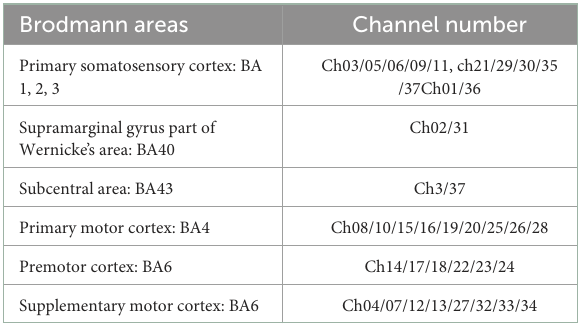
TABLE 2 List of fNIRS channels corresponding to Brodmann